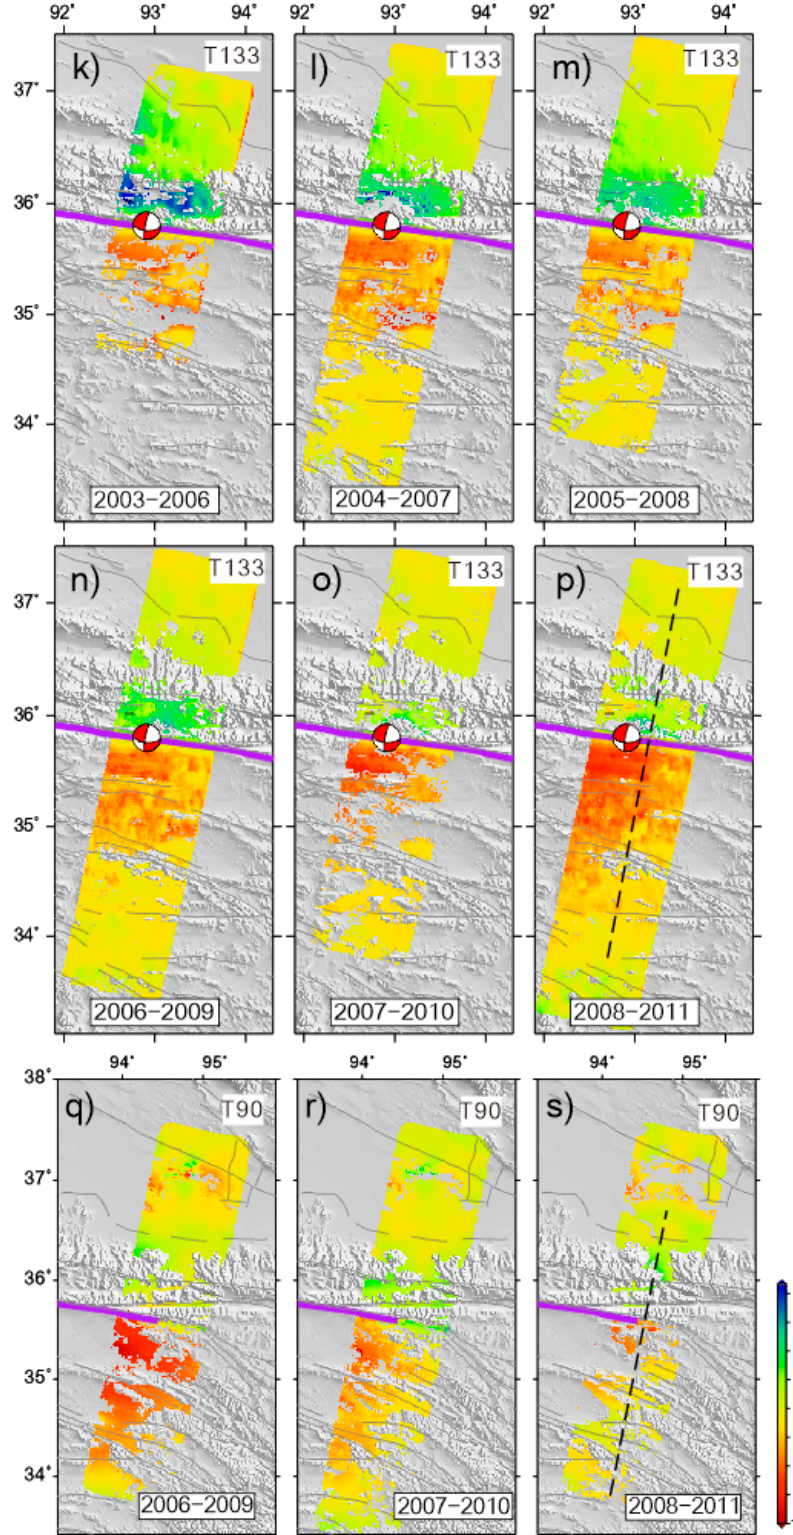
Figure 7. Average line of sight (LOS) postseismic velocity maps for track 448 ( a - c ), 176 ( d - g ), 405 ( h - j ), 133 ( k - p ) and 90 ( q - s ). Fault traces, beach ball and surface ruptures caused by the 2001 event are as in Figure 1. The dark line in ( c ), ( g ), ( j ), ( p ) and ( s ) is the profile location in Figure 8.